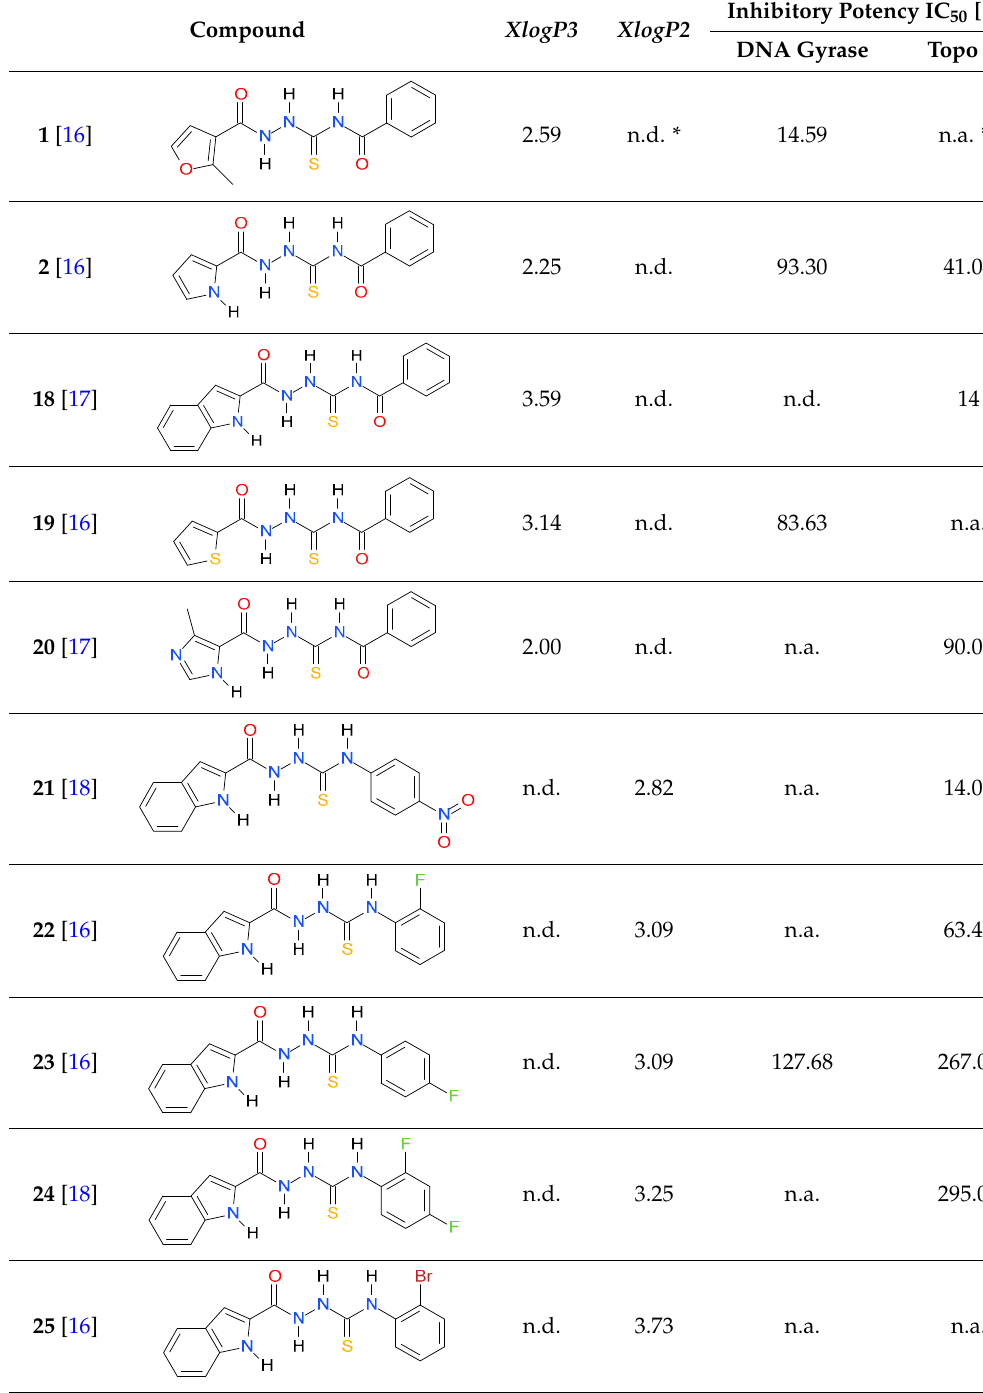
Table 5. Structures and inhibitory potency of thiosemicarbazides 18 – 34 towards bacterial topoisomerases. Compound